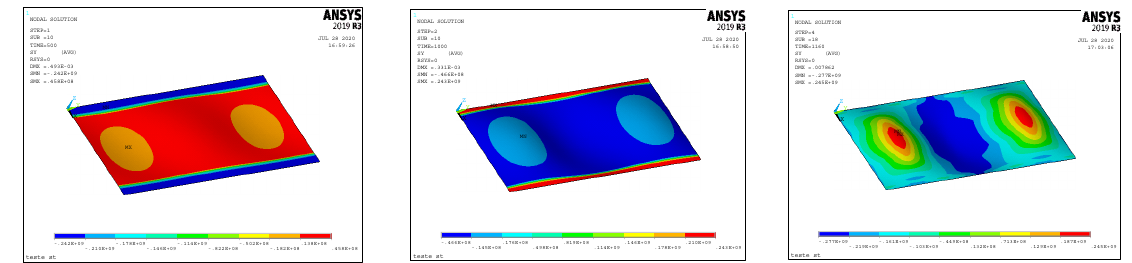
Figure 3. Example of state of stresses of a plate after HAZ heating ( left ), HAZ cooling ( middle ) and at collapse ( right ).